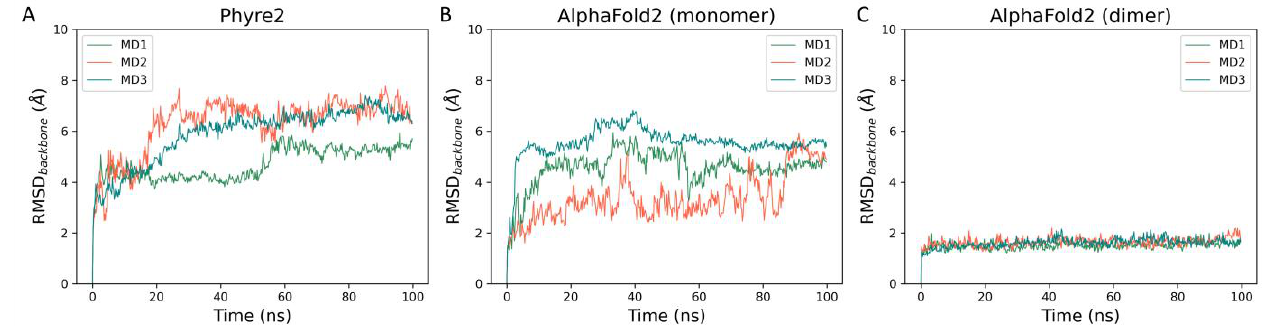
Figure 3. This panel showcases the time-dependent evolution of the backbone RMSD calculated throughout molecular dynamics simulations performed on each of the three I7L protease models: ( A ) Phyre2 model (monomer), ( B ) AlphaFold2 model (monomer), and ( C ) AlphaFold2 model (dimer).